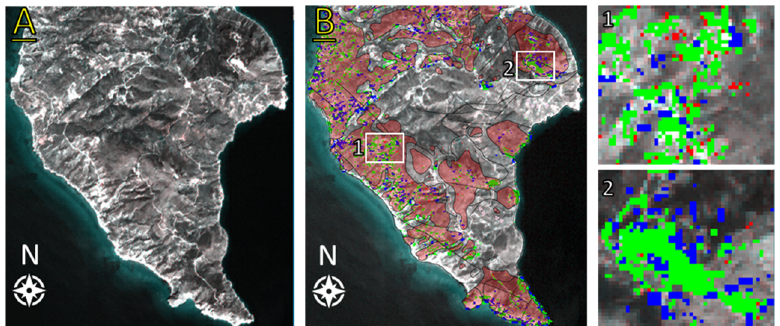
Figure 4. ( A ) Radiometrically calibrated and atmospherically corrected ASTER image of Kefalos peninsula; ( B ) Spatial distribution of kaolinite (green), dickite (red) and kaolinite/smectite (blue) derived from MTMF algorithm related with volcanic rocks (in red areas). Areas in numbered white boxes are displayed on the right, on a magnified scale, representing the small occurrence of dickite and kaolinite/smectite compared to kaolinite in west Kefalos (1) and the perlite quarry (2).